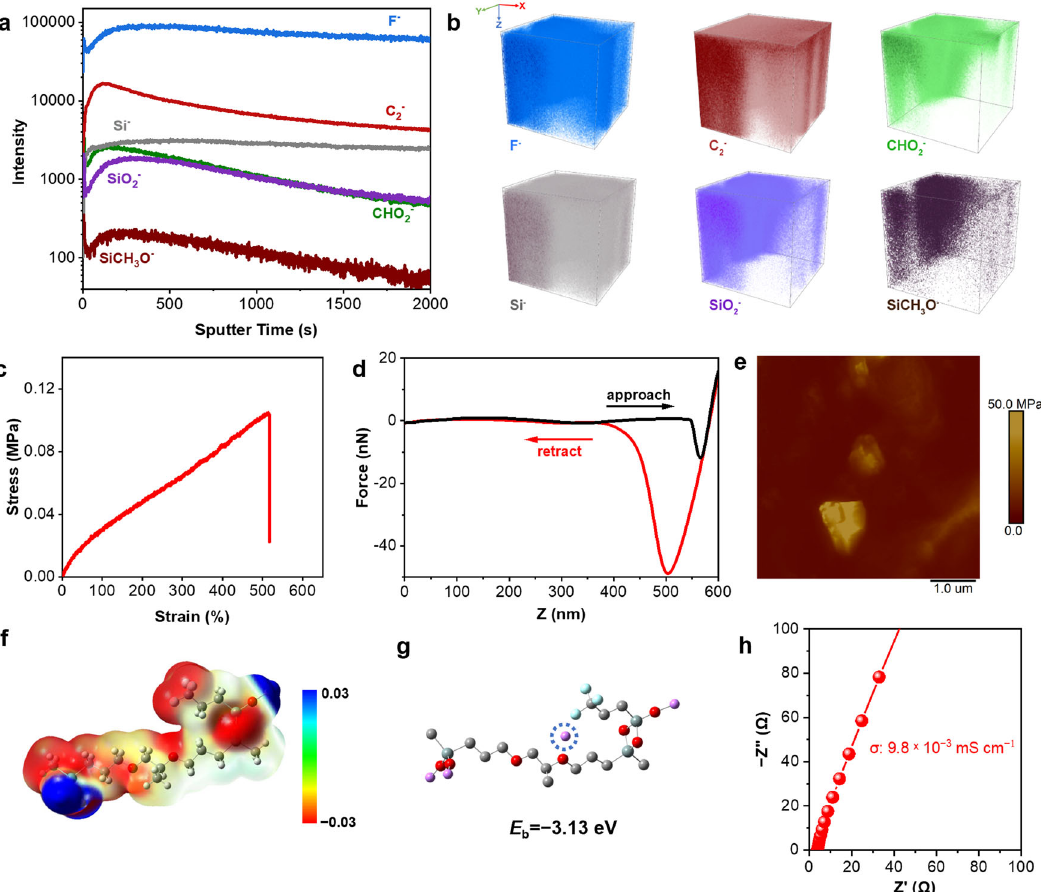
Fig. 2 Characterizations of jigsaw-like arti fi cial FO – Si layer. a TOF-SIMS depth pro fi les of selected secondary-ion fragments on the surface. b The 3D view images of the sputtered volume corresponding to the depth pro fi les. c Tensile stress – strain curve. d Typical force – displacement curve. e AFM Young ’ s modulus mapping. f The electrostatic potential. g Binding energy with Li + . h Electrochemical impedance spectrum for ionic conductivity